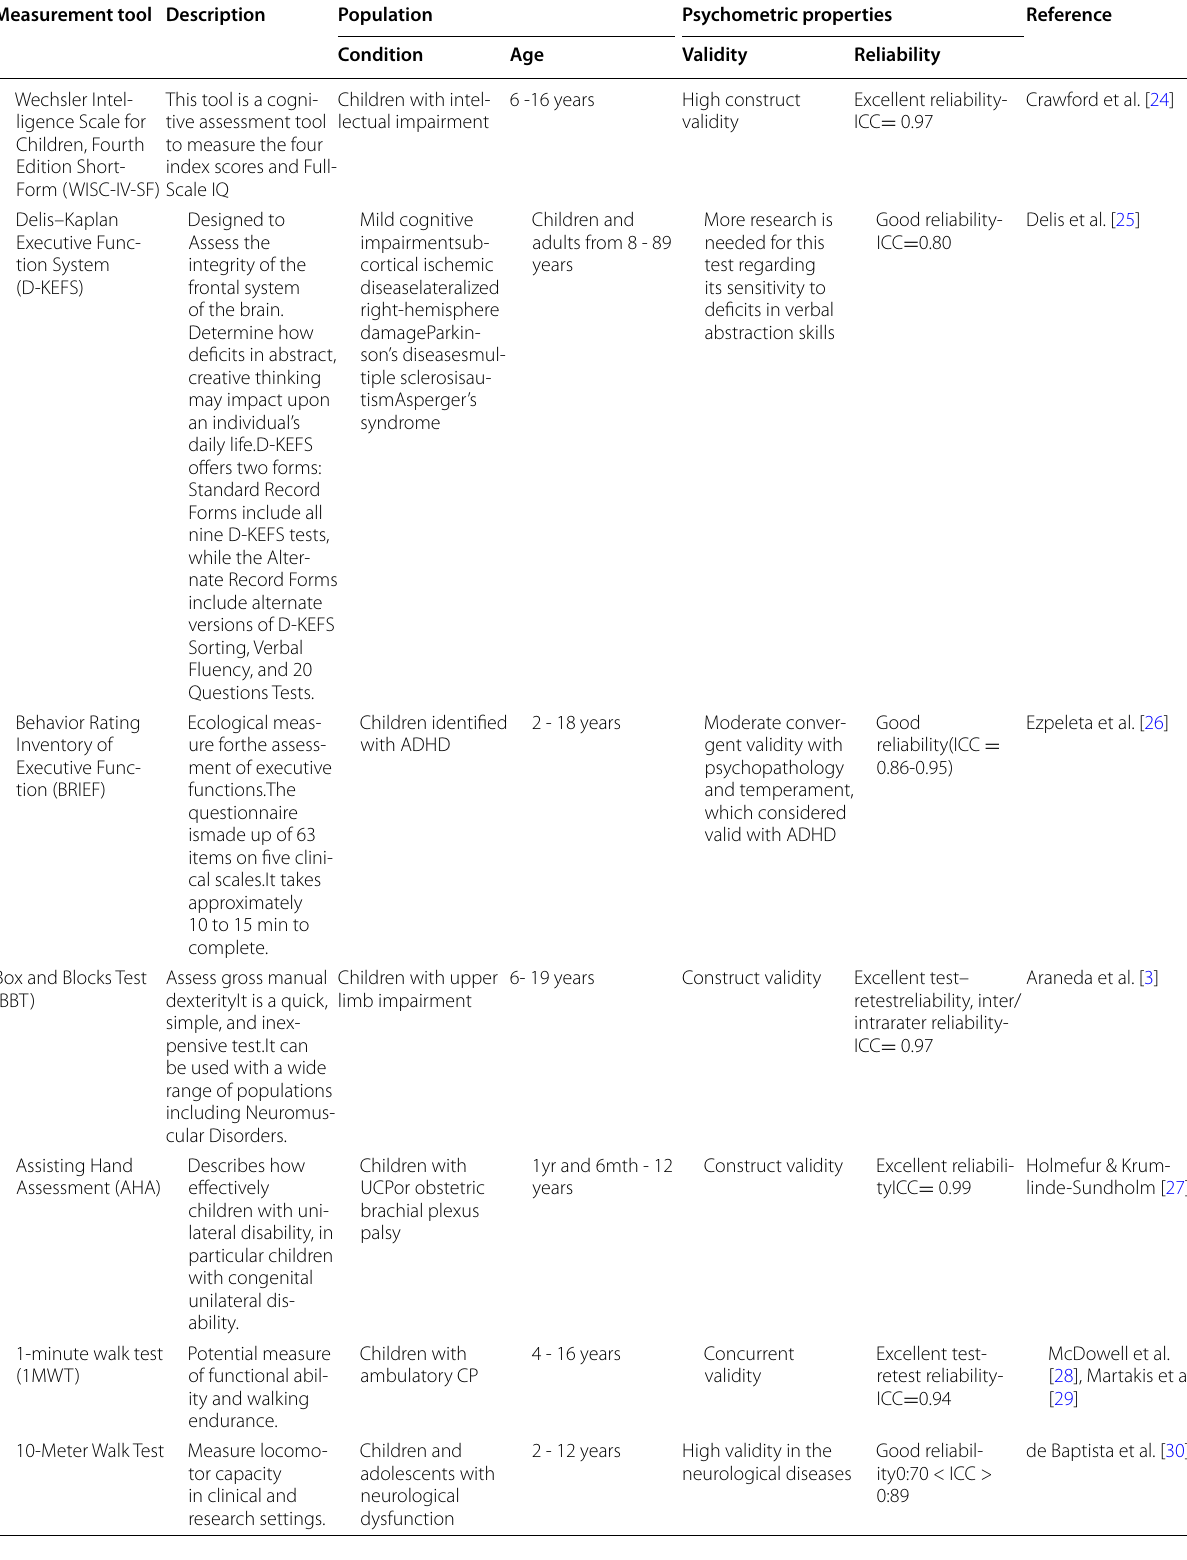
Table 4 Outcome measures description and psychometrics Measurement tool